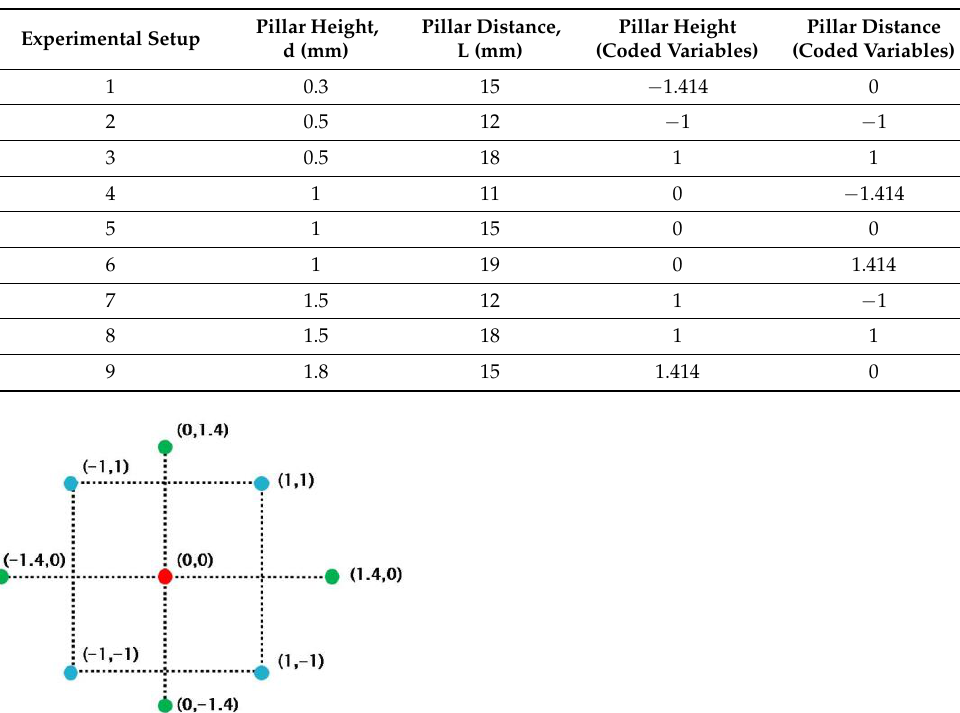
Table 1. Parameter setting in central composite design of the optimization.